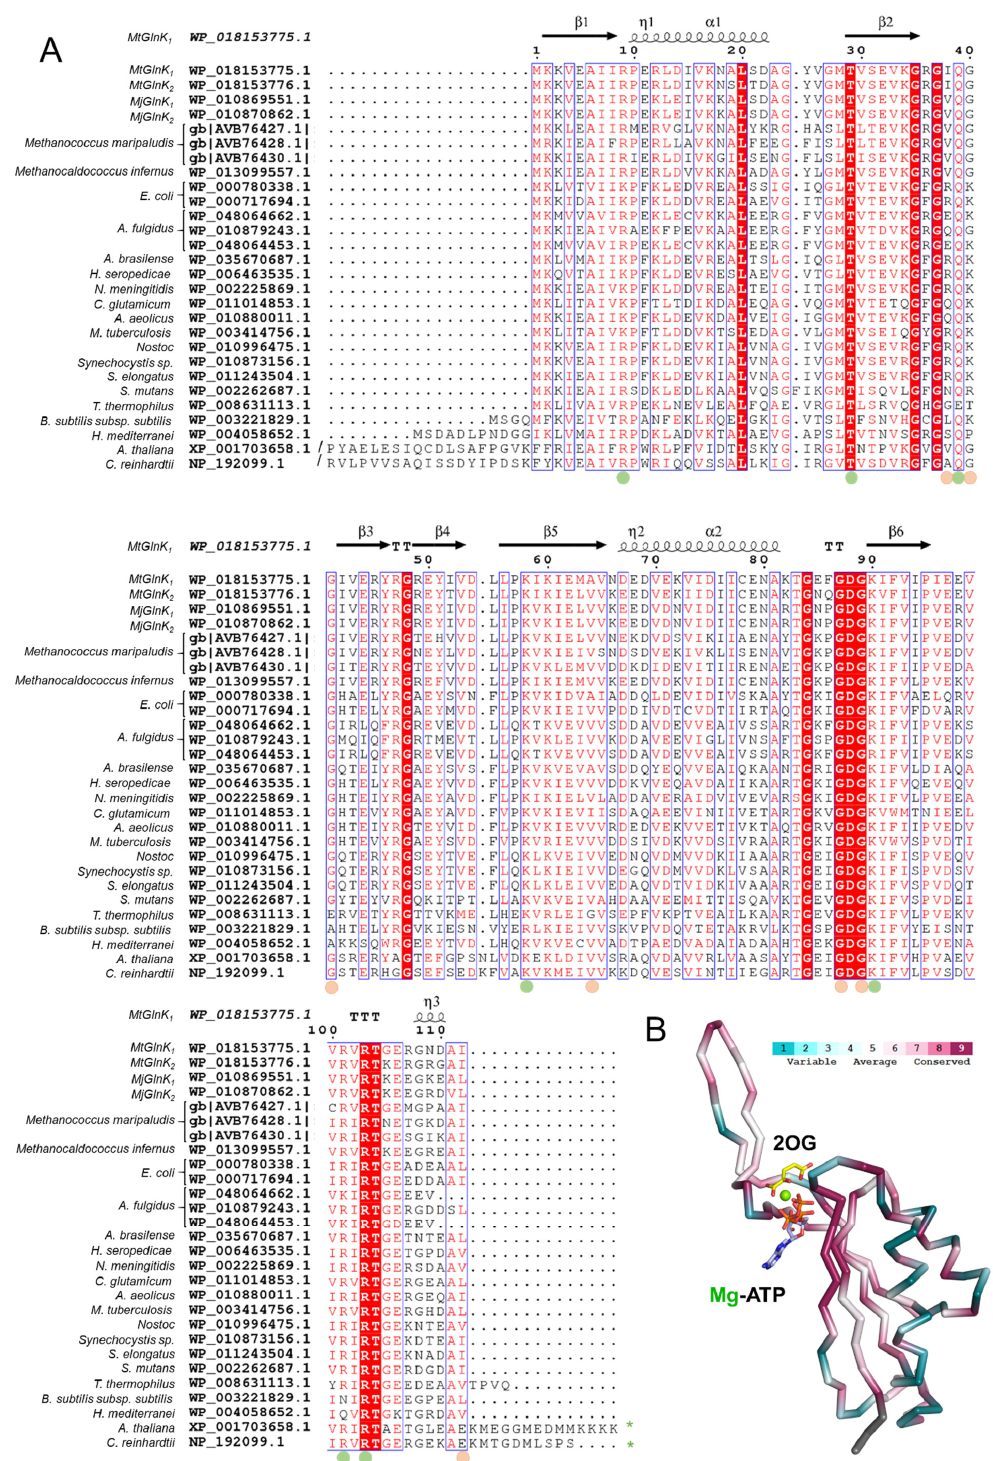
Figure 4. Sequence conservation among structurally characterized P II members with the addition of various Methanococcales (see Supplemental materials for the full names). ( A ) Sequences were aligned with Clustal omega and processed with Espript 3.0. Mt GlnK 1 was used as a reference for the secondary structure. Dots indicate residues involved in ligand binding via side chain (green) or main chain (orange). Green stars indicate a C-terminal extension (Q-loop). ( B ) Sequence conservation score superposed on the 3D-structure of Mt GlnK 2 -Mg-ATP/2OG monomer processed via the ConSurf Server [25,26]. The conservation is represented as a color gradient, from blue (variable) to dark red (conserved). Nitrogen, oxygen, phosphorus and Mg are colored in blue, red, orange and green, respectively. Carbons of 2OG and ATP are colored yellow and pale blue,